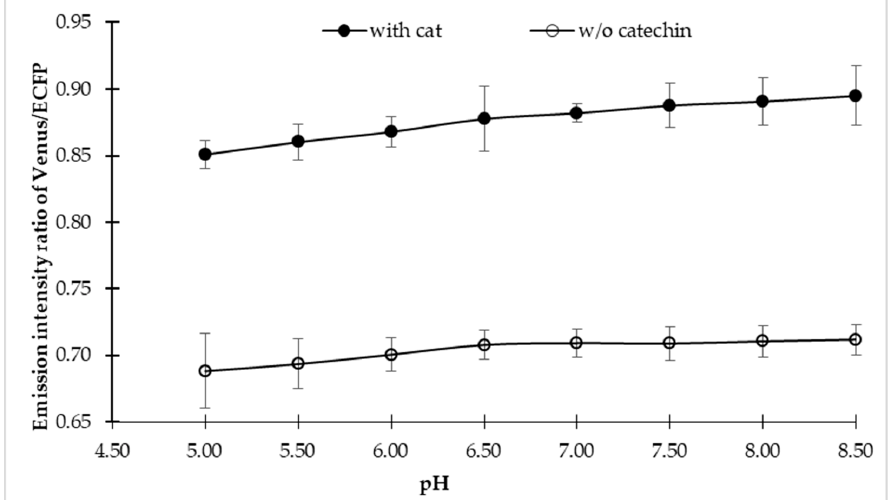
Figure 2. pH stability of FLIP-cat sensor. pH stability of FLIP-Cat was performed by dissolving the purified protein of FLIP-Cat in 3-(N-morpholino) propane sulphonic acid (MOPS) buffer of various pH range (5–8.5) and monitoring the emission intensity ratio of Venus/enhanced cyan fluorescent protein (ECFP). Plotted values are means of three independent replicates. Vertical bar indicates the standard error.